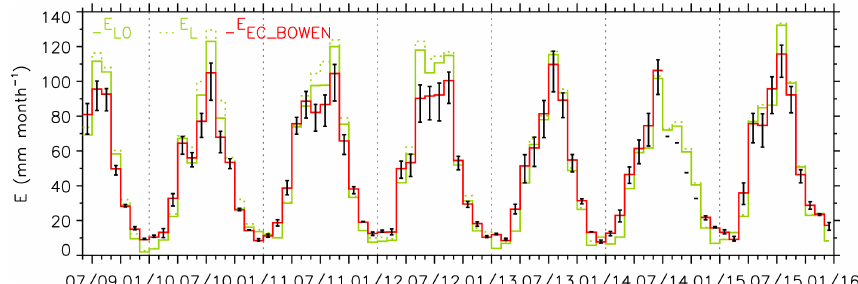
lysimeter evap- 0